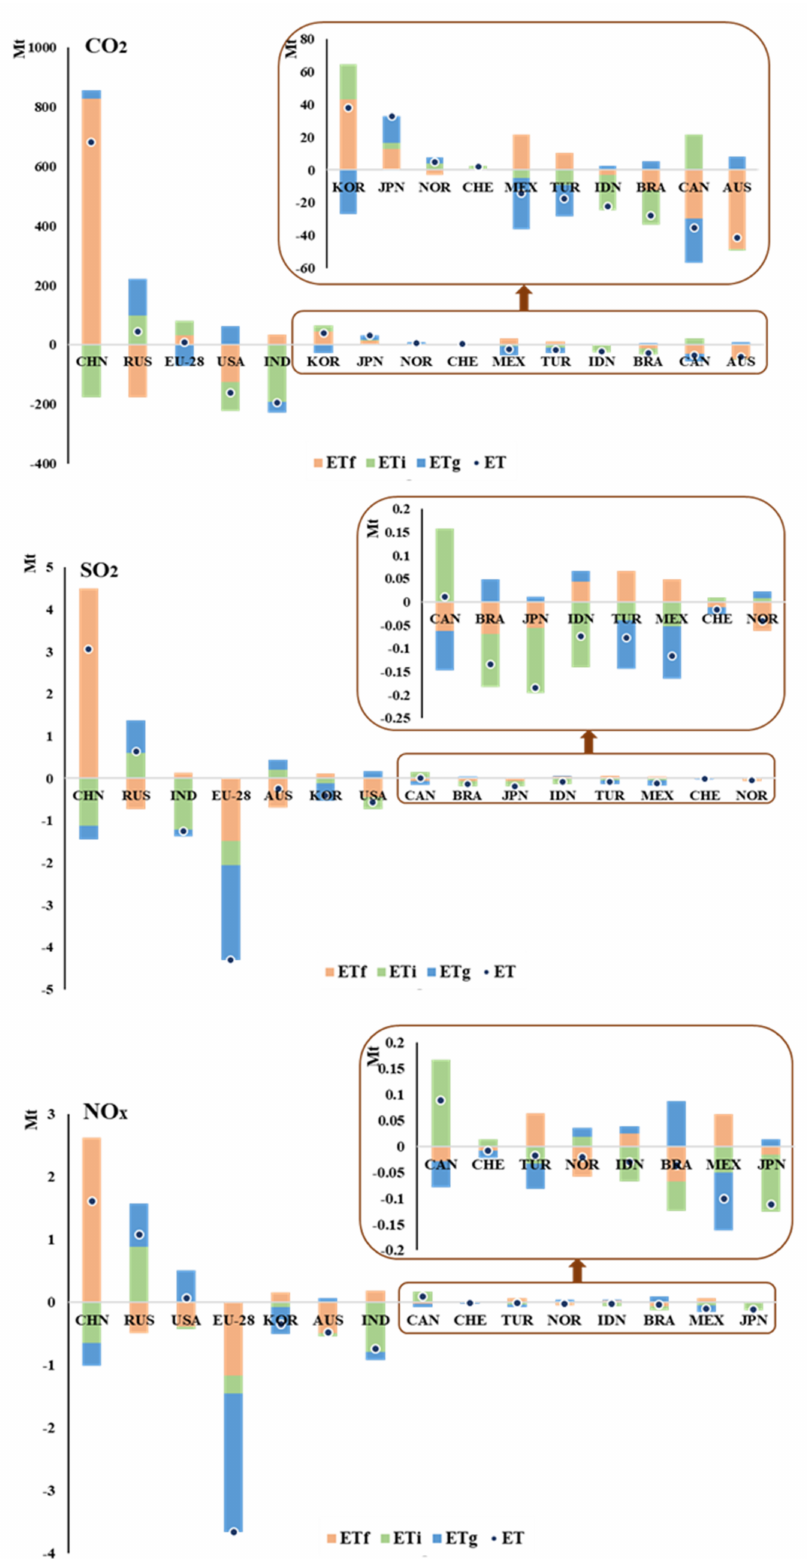
Figure 5. Assess major countries in different patterns of pollution haven. See Tables A6 and A7 for the full name of the